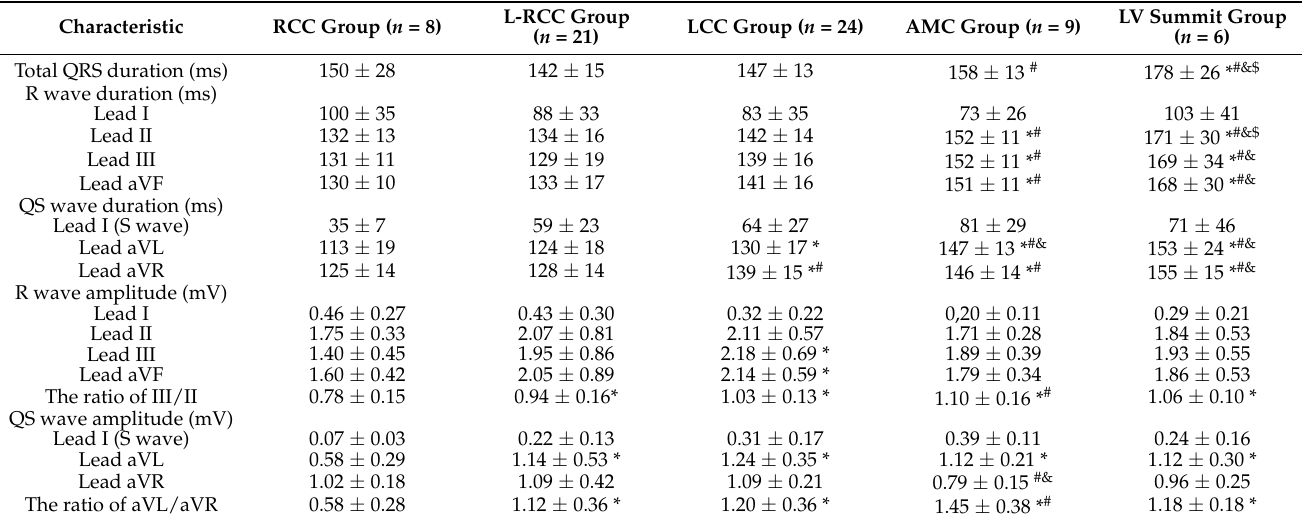
Table 2. Comparison of ECG characteristics of limb leads.